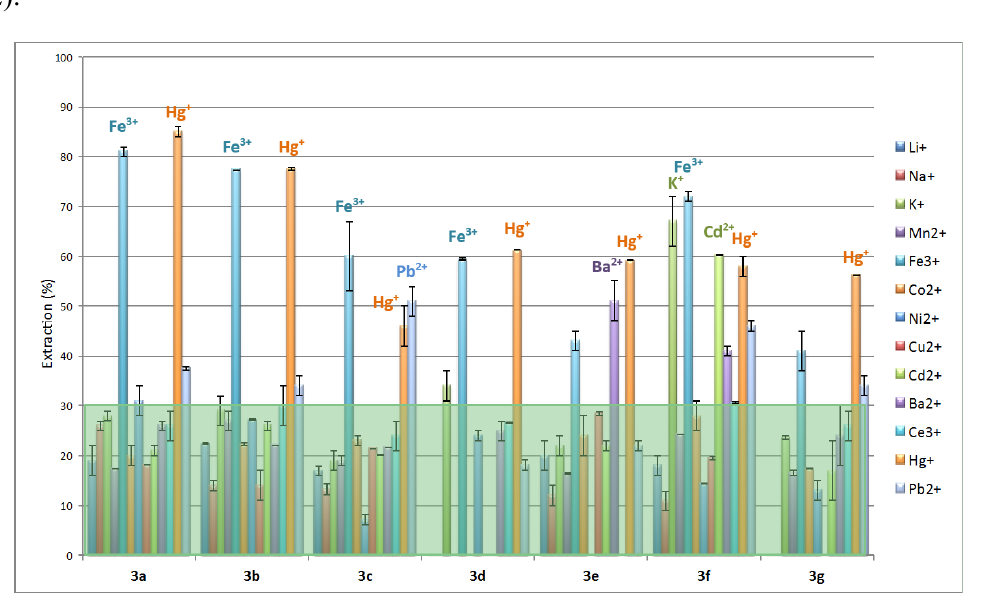
Figure 3. Extraction efficiencies of metal cations by the triazolic piperazine polymers 3a – 3g (cations extracted at levels ≥50% are